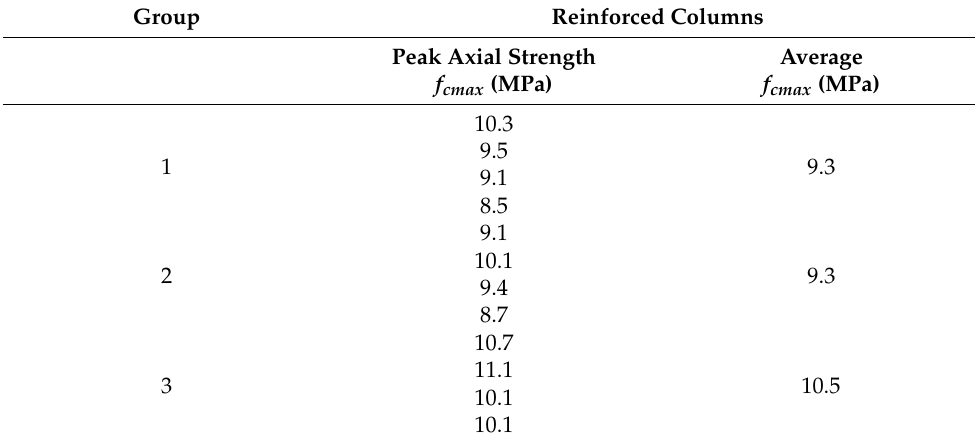
Table 6. Results of reinforced columns reported in